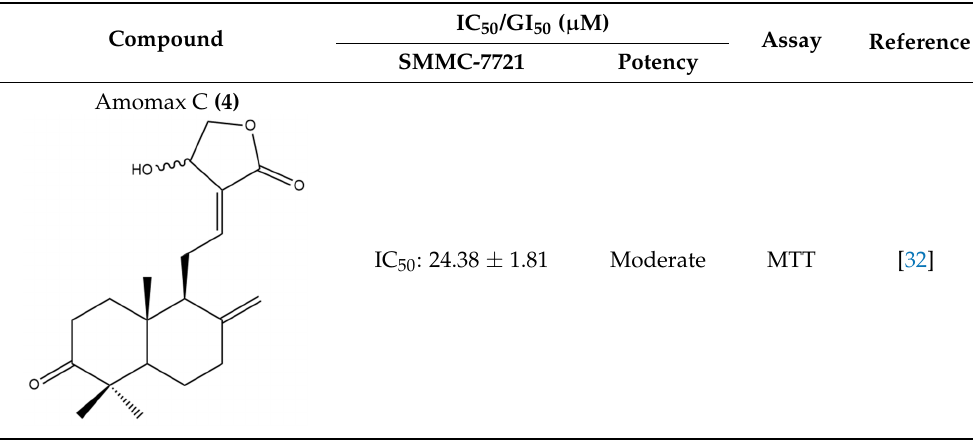
Table 8. Cytotoxic activities of labdane-type diterpenes from the Zingiberaceae against SMMC-7721 cervical cancer cell line.